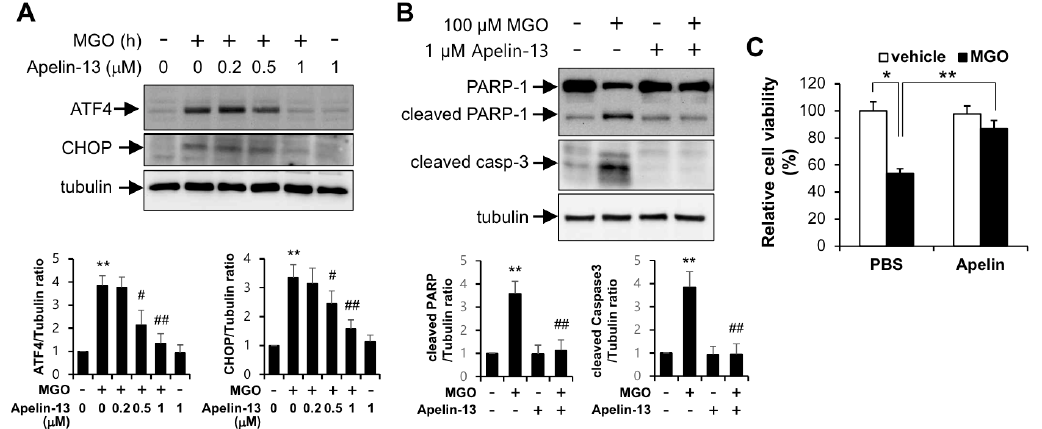
Figure 2. Apelin-13 protects endothelial cells from MGO-induced UPR and apoptosis. HUVECs were pretreated with 1 µ M apelin-13 for 1 h followed by exposure to 100 µ M MGO for 6 or 24 h. ( A ) Cells were exposed to 100 µ M MGO for 6 h in the presence or absence of apelin-13 (0, 0.2, 0.5, 1 µ M). Amount of protein expression was determined by immunoblotting with specific antibodies against ATF4, CHOP, and tubulin. Bar graphs represent the densitometric results of Western blot bands. ** p < 0.01 vs. vehicle control, # p < 0.05; ## p < 0.01 vs. MGO-treated cells ( n = 3). Results are representative of three independent experiments. ( B ) HUVECs were lysed and then applied for Western blotting analysis. Protein level amounts were determined by immunoblotting with anti-PARP-1 and anti-caspase-3 antibodies. The graph shows the densitometric quantification of Western blot bands. ** p < 0.01 vs. vehicle control, ## p < 0.01 vs. MGO-treated cells ( n = 3). Results are representative of three independent experiments. ( C ) MTT assay was performed as described in the Materials and Methods section. Results are expressed as means ± SDs and are representative of three independent experiments. * p < 0.05; ** p < 0.01 ( n = 3).